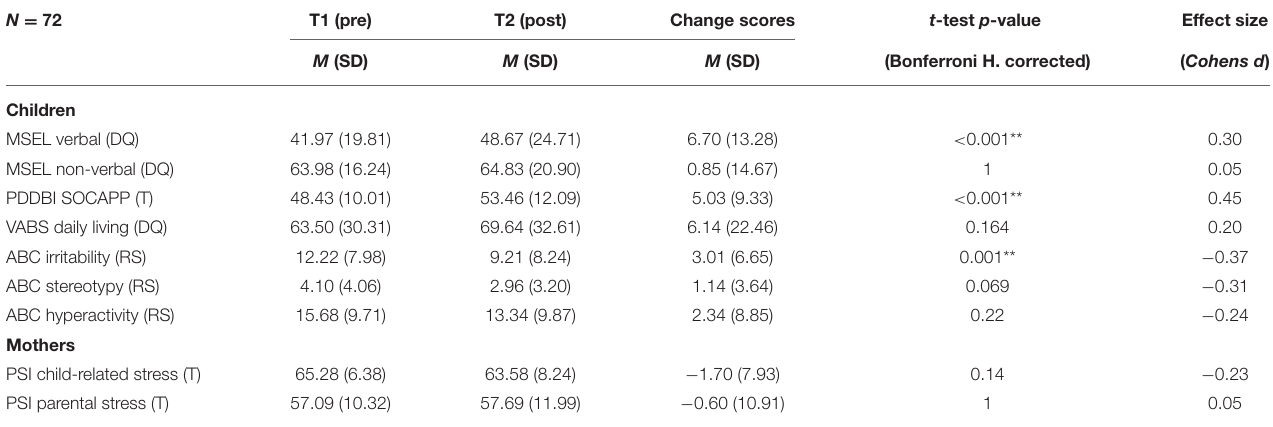
TABLE 1 | Developmental and behavioral differences between T1 and T2 (pooled t -tests). N = 72